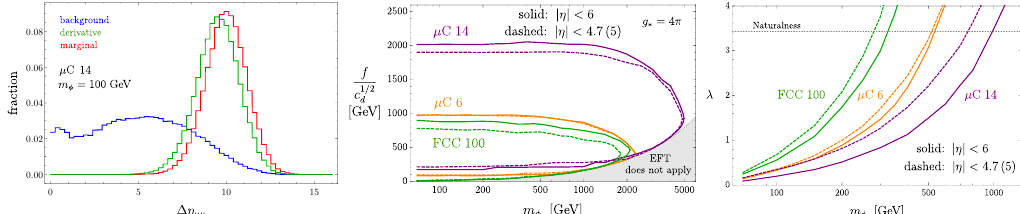
Figure 5: Left: normalized ∆ η µµ distributions for the signals with m φ = 100 GeV (cid:112) s = 14 TeV. Only for this plot, the and the background at a muon collider with generation-level cut on the muon pseudorapidity was relaxed to | η µ | < 8. Middle: projected 95% CL constraints on the derivative portal at FCC 100 and at a muon collider, assuming the forward detector coverage extends up to | η | = 6 (solid) or | η | = 4.7 [ 5 ] for the FCC [ muon collider ] (dashed). Right: same as the middle panel, for the marginal